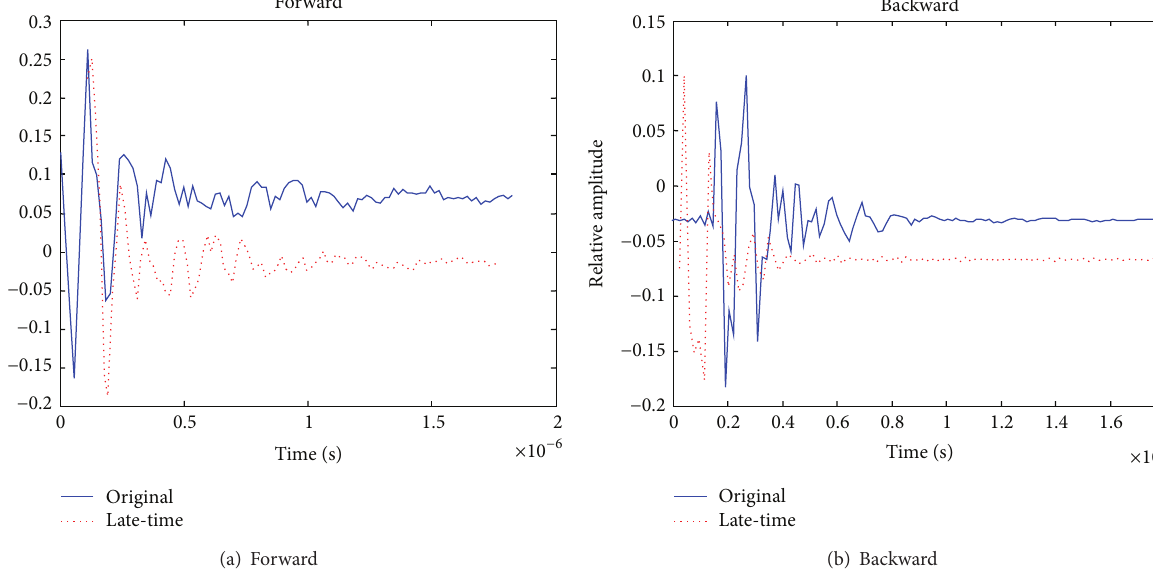
Figure 4: The comparison between original RCS and the RCS recovered only by late time response in time domain. (a) The angle between the incident and the bow is 0 ∘ . (b) The angle between the incident and the bow is 180 ∘